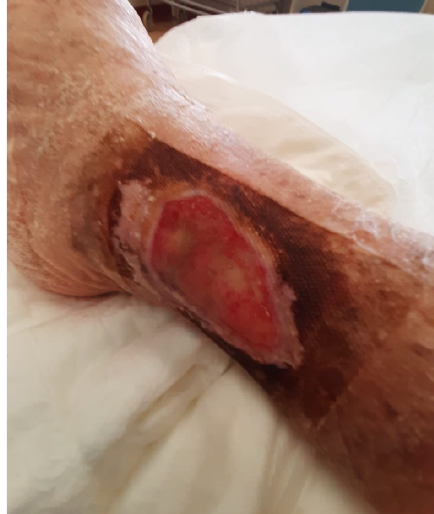
Figure 1. Ulcer at